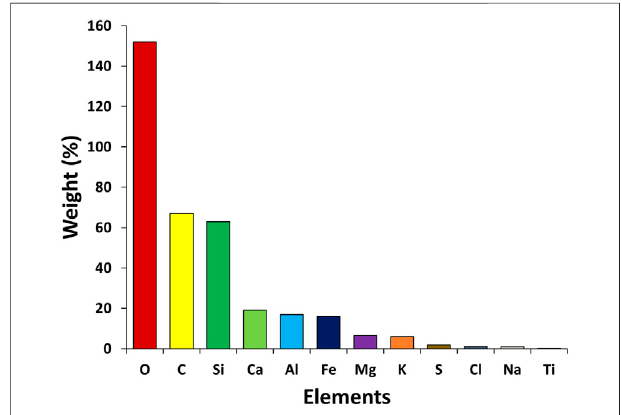
FIGURE 6 | Average elemental weight percent in the area in Nowshera